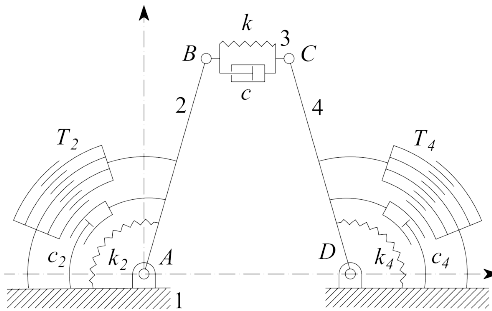
Figure 4. The schematic gripper layout in the initial configuration.